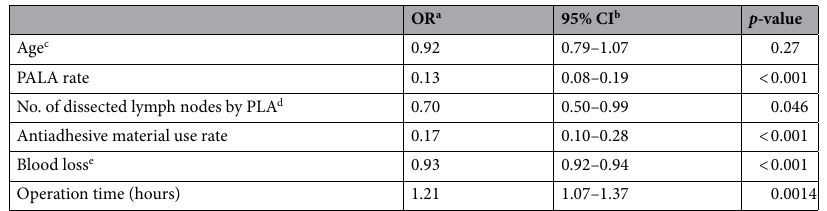
Table 3. Multivariate analysis of laparoscopic surgeries group compared with open surgeries group. a Odd